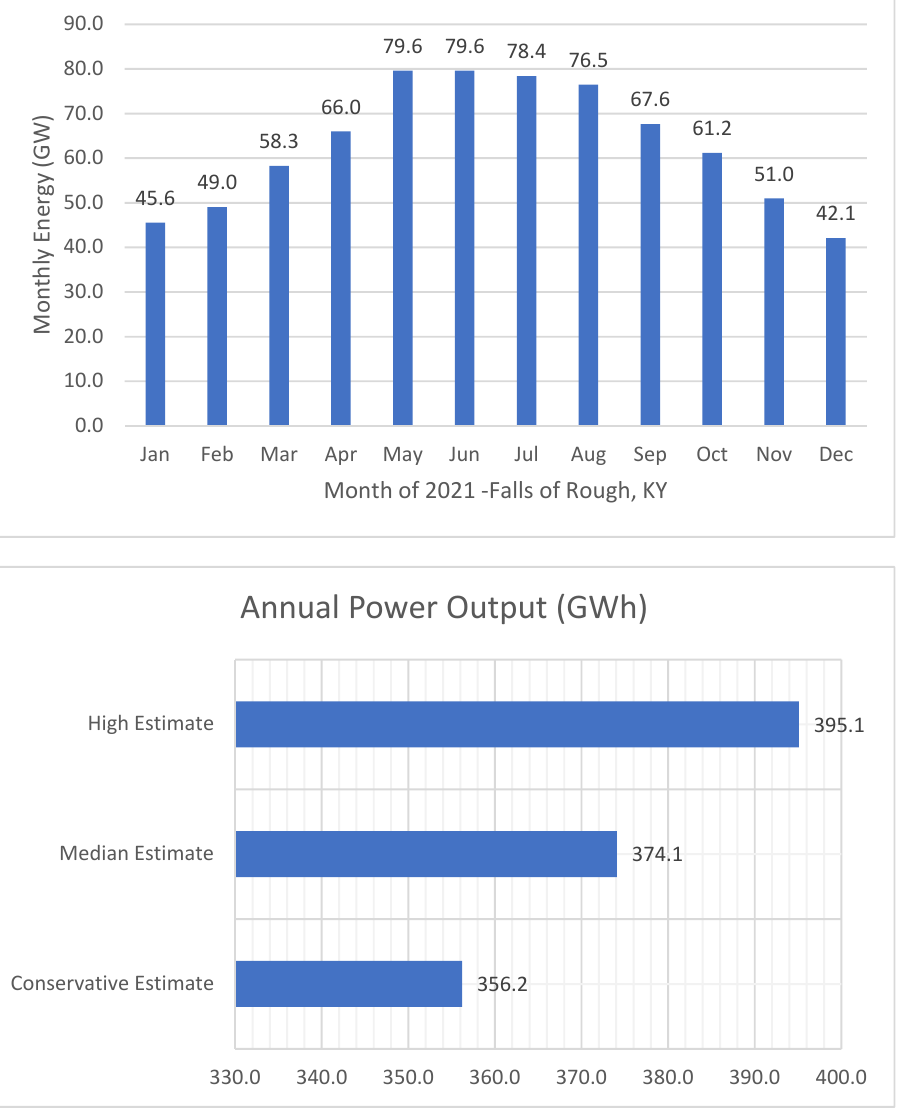
Figure 19 . Graphs of estimated GWh produced over a one-year period for potential Falls of Rough solar farm monthly (21.1: Upper ) and annually (21.2: Lower ) [27,29].